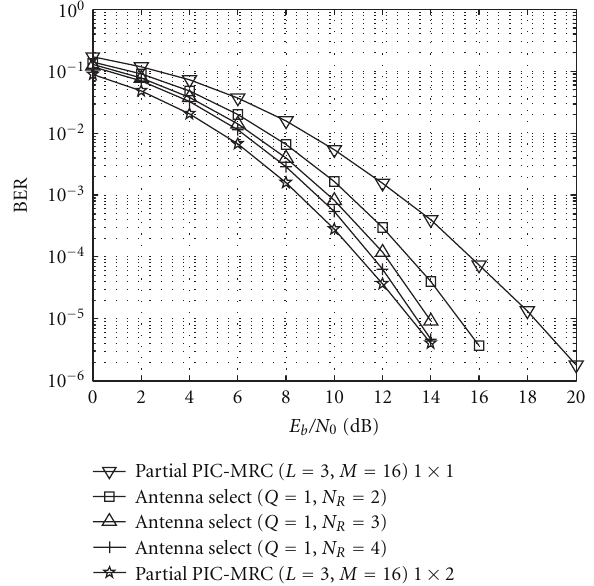
Figure 15: BER performance of partial PIC-MRC with antenna selection